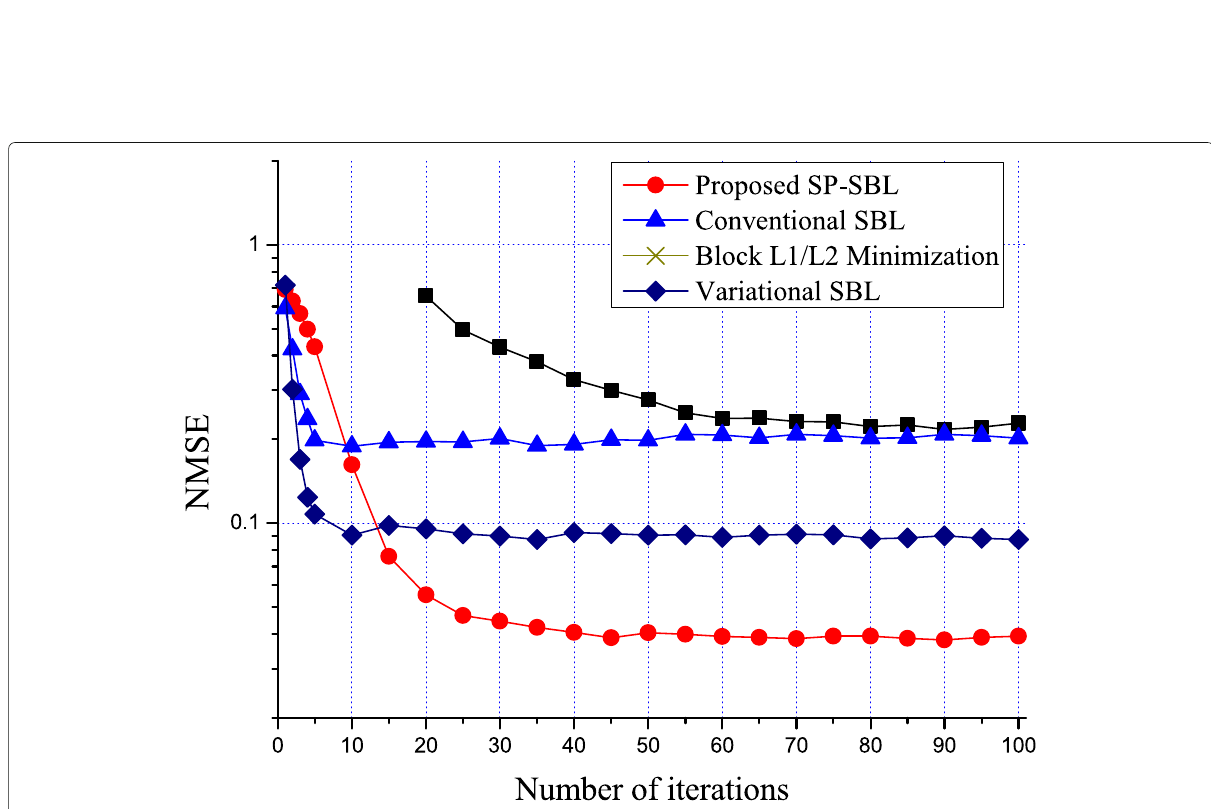
Fig. 8 NMSE performance for different numbers of iterations, where N = 64. The length of pilot sequence is T = 16. Transmit SNR of BS is NP = 15 dB. The angular spread is (cid:3) σ 2